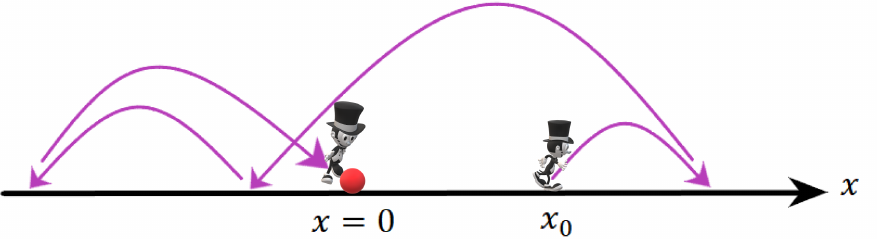
Figure 1. Schematic of the random search process. A walker starts its motion from x 0 and performs random jumps in the search space until he finds the target at x =